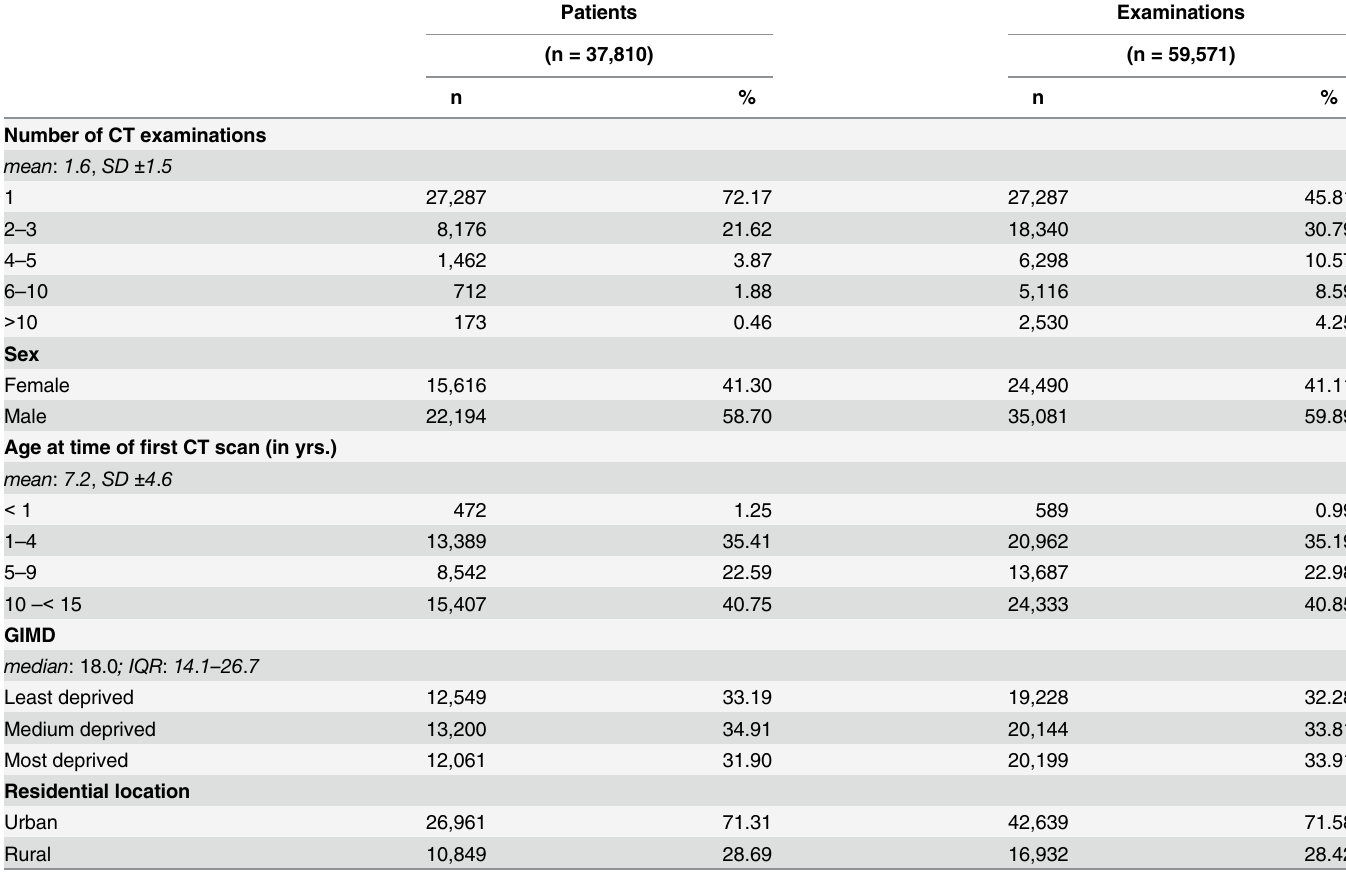
population (median: 18.0; interquartile range: 14.1 – 26.7) and for all municipalities in Germany (median: 18.9; interquartile range: 13.5 – 26.4), with a marginal overrepresentation of